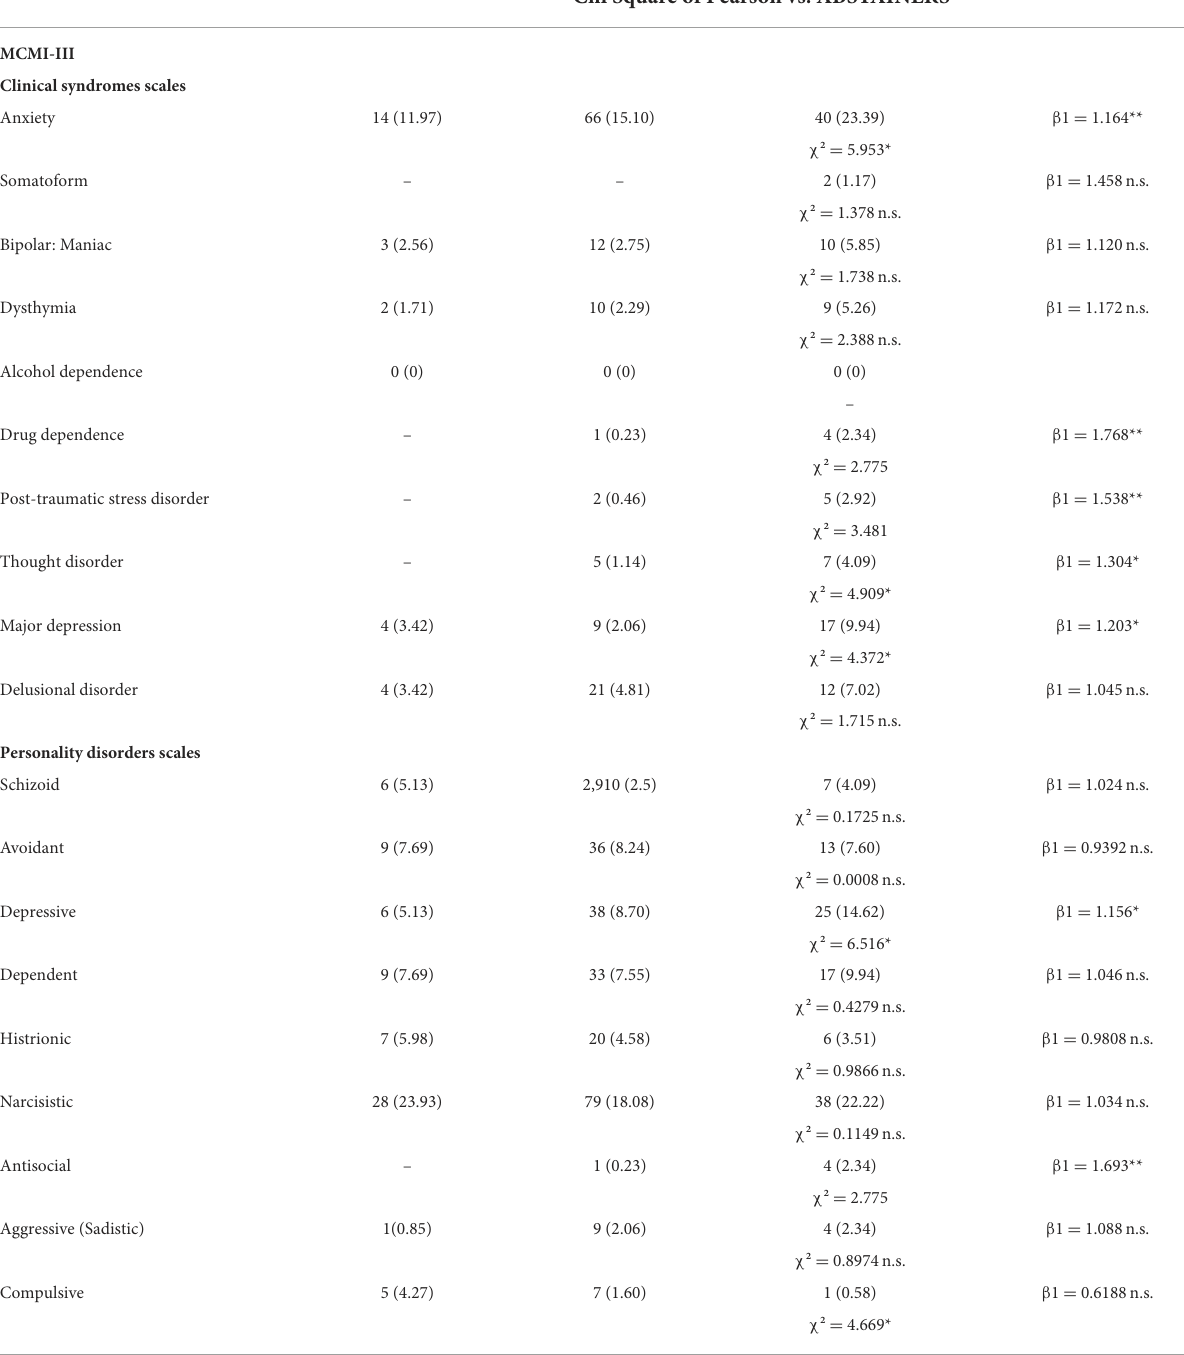
Abstainers Moderate drinkers Binge drinkers TEST Frequency (%) Chi Square of Pearson vs.